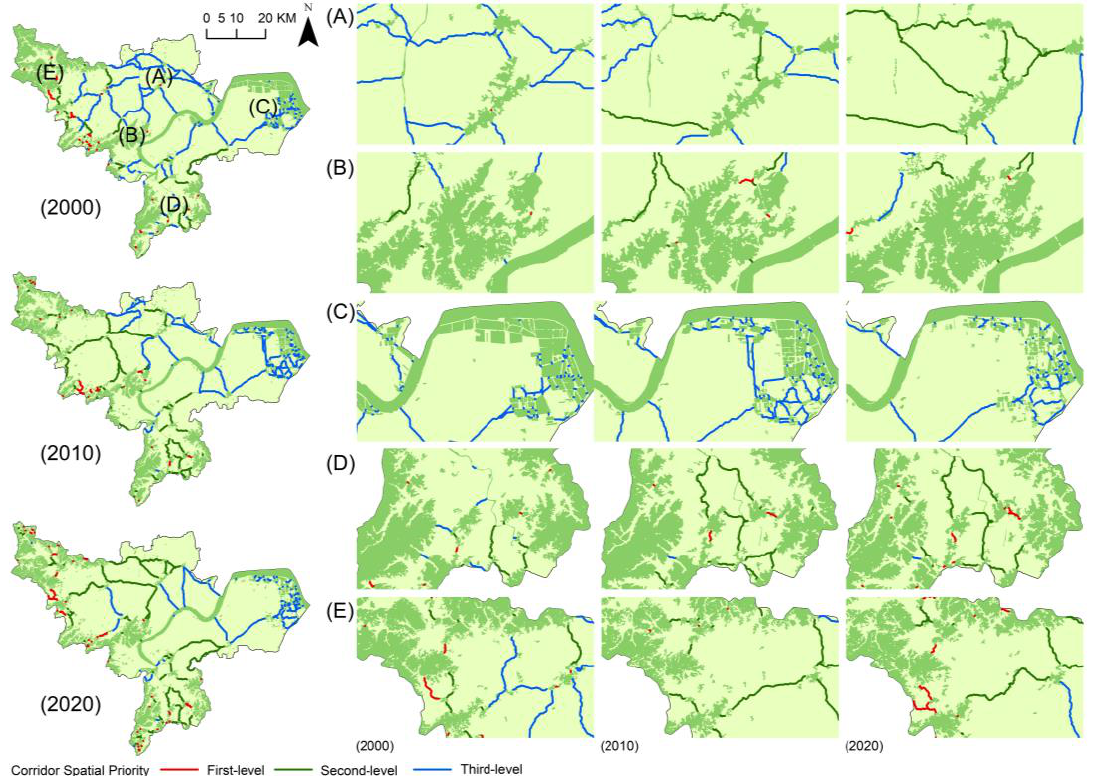
Figure 6. GI corridors’ spatial priority distribution at all levels in 2000, 2010, and 2020: ( A ) Banshan National Forest Park, ( B ) West Lake Scenic Area, ( C ) Qiantang River Wetland, ( D ) Shiniu Mountain– Qinghua Mountain Scenic Area, and ( E ) Jingshan Scenic Area.